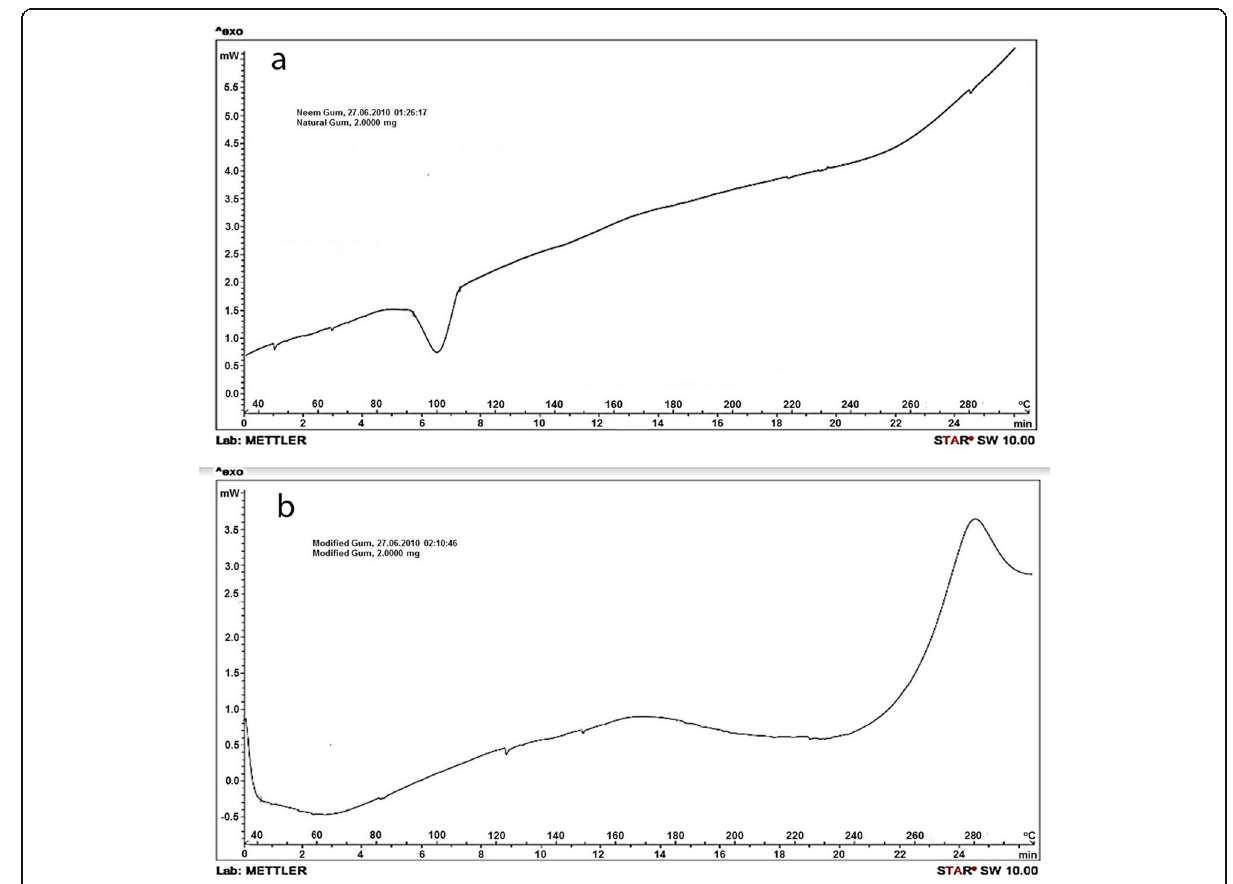
Fig. 2 DSC Graph of a neem gum and b modified neem